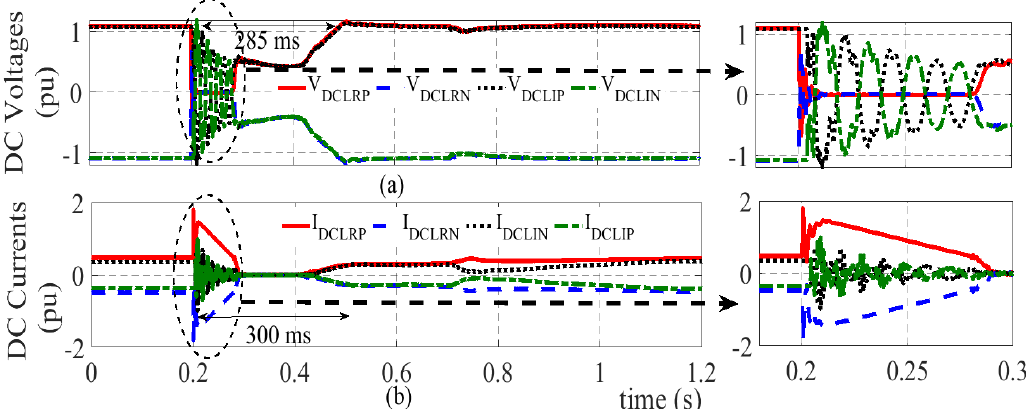
Figure 10. DC side measurements at LCC stations for a P-Pole-to-N-Pole fault on the main transmission line ( a ) voltages, ( b ) currents. Shown to the right of each plot is a zoomed view of the initial transient period.